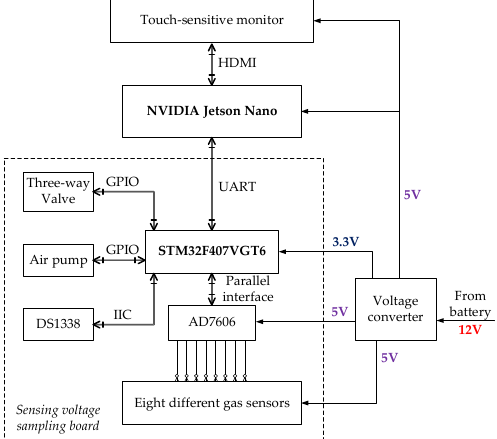
Figure 4. Structure of the electronic hardware in SMUENOSEv2. The blocks inside the dashed rec- tangle belong to the sensing voltage sampling board.